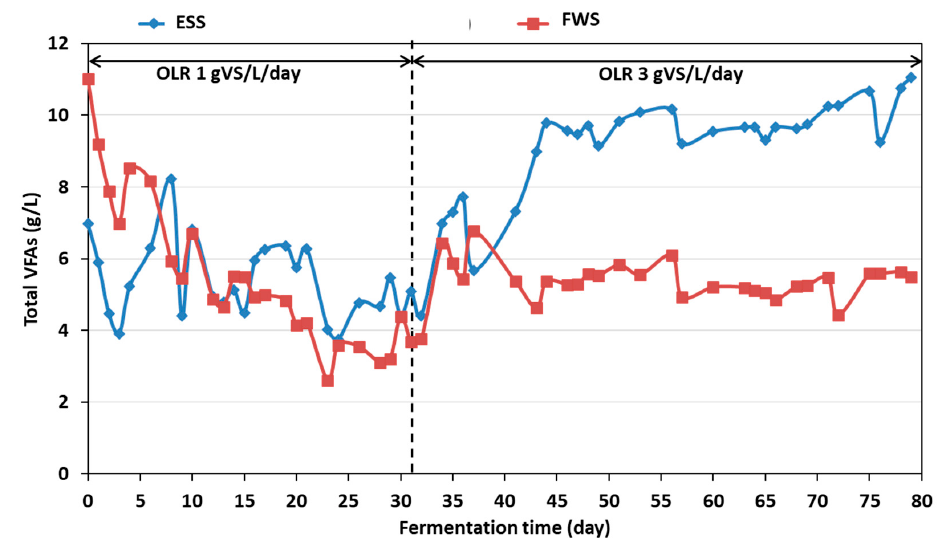
Figure 10. The concentration profiles of VFAs recovered from membrane bioreactors (MBRs) fed with excess sewage sludge and food waste slurry.